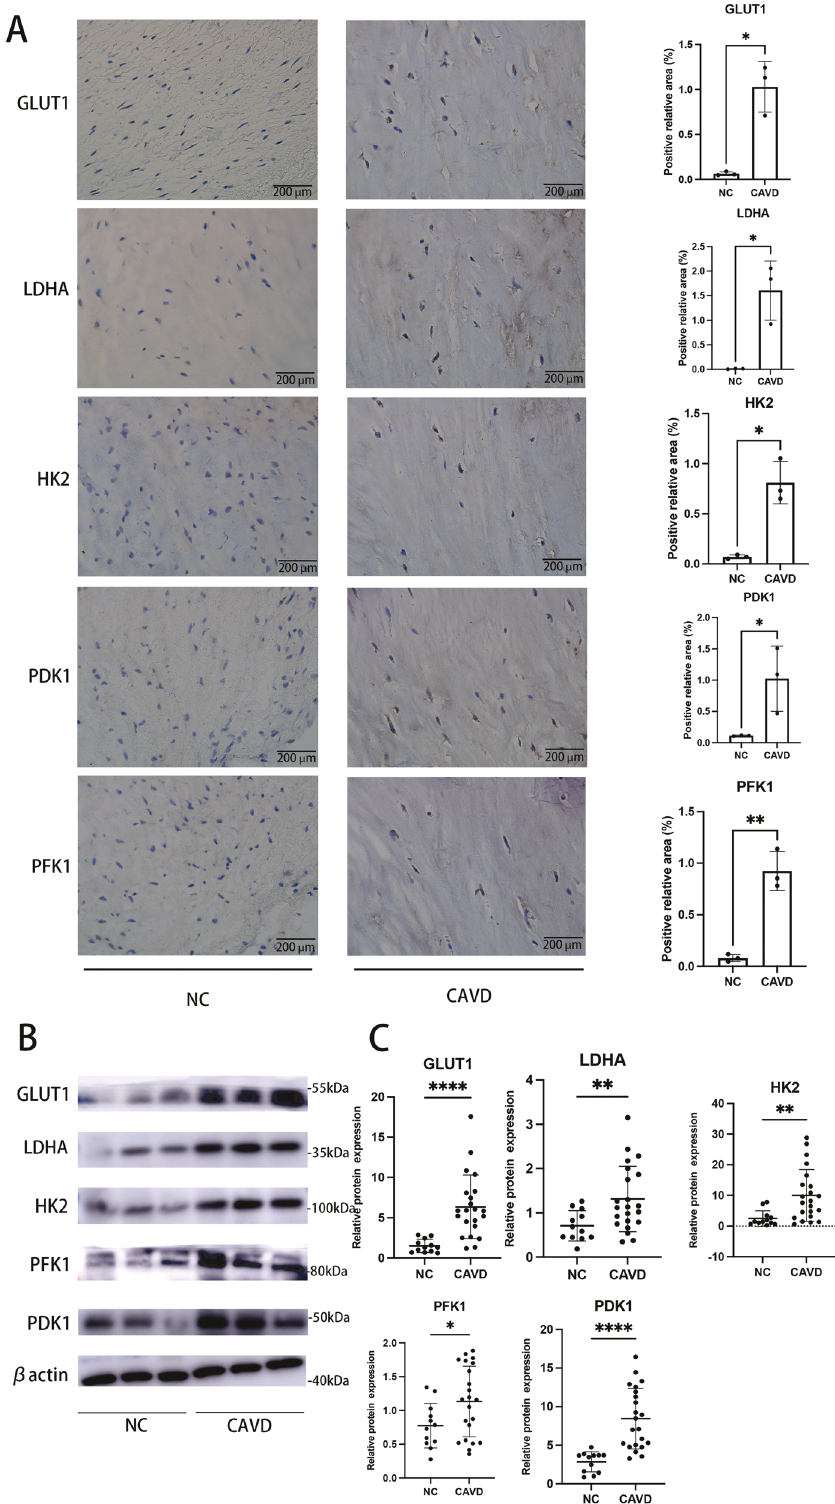
Fig. 6 Warburg-associated key proteins are upregulated in human calci fi ed aortic valves. A Representative immunohistochemical images, and quanti fi cations for % GLUT1 + , % LDHA + , % HK2 + , % PFK1 + and % PDK1 + area in human aortic valves with and without CAVD (Unpaired two-tailed Student ’ s t-test with Welch ’ s correction for GLUT1, HK2 and LDHA; unpaired two-tailed Student ’ s t-test for PDK1 and PFK1). Scale bar = 200 µm. B Representative images and ( C ) quanti fi cations of western blot of GLUT1, LDHA, HK2, PFK1 and PDK1 in human calci fi ed aortic valves ( n = 22) versus control ( n = 12) (Unpaired two-tailed Student ’ s t -test for GLUT1 and PFK1; Mann – Whitney test for HK2; unpaired two- tailed Student ’ s t -test with Welch ’ s correction for LDHA and PDK1). β -actin was used as loading control. Data are shown as mean ± SD. * P < 0.05, ** P < 0.01, *** P < 0.001, **** P < 0.0001.